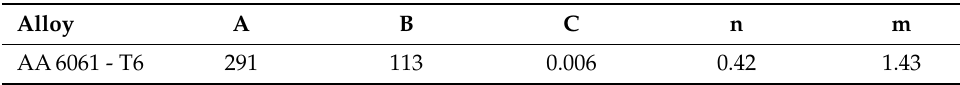
Table 2. Johnson–Cook parameters for